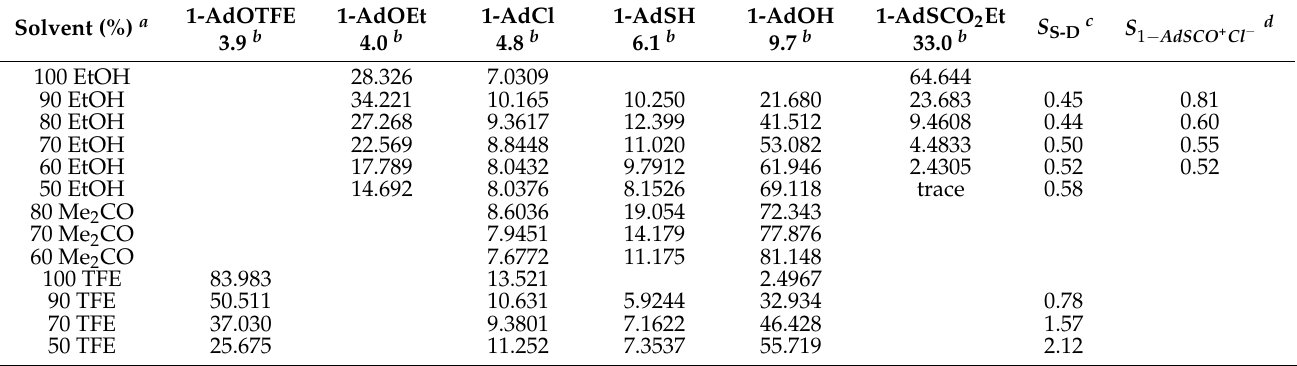
Table 3. Percentages of products formed in the solvolysis of 1 in various hydroxylic solvents at 25.0 ◦ C and the calculated selectivity ( S )